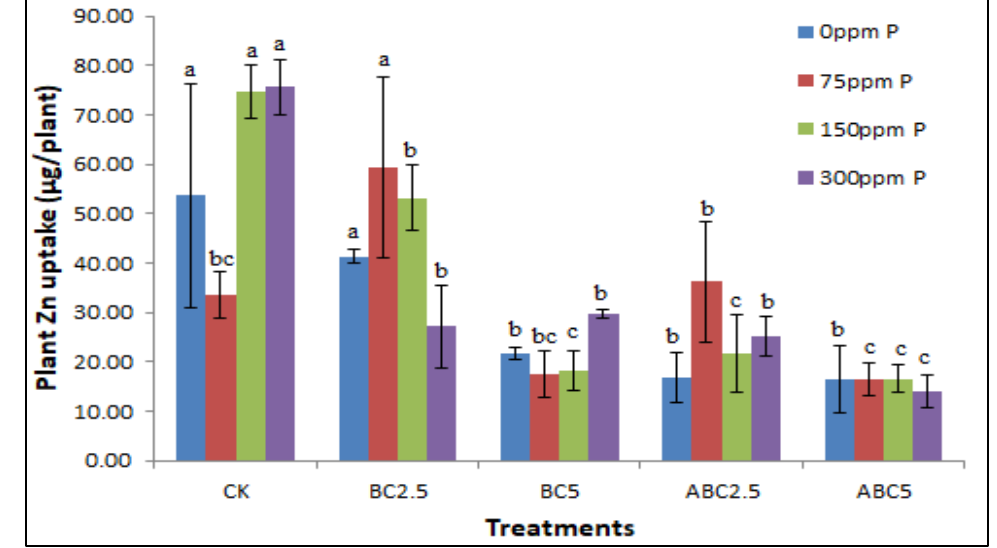
Figure 13. Effects of BC and ABC applied at different rates with different P fertilizer application rates on Plant Zn uptake ( μ g/plant). Means with different letters within each fertilizer rate across each treatment indicate significant differences according to the least significant difference (LSD) test at p < 0.05. CK = Control, BC2.5 = Biochar added at 2.5% w / w , BC5 = Biochar added at 5% w / w , ABC2.5